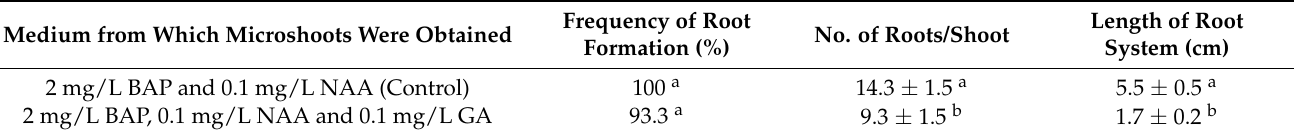
Table 9. Root formation and growth as influenced by GRs interaction and culture for three weeks on